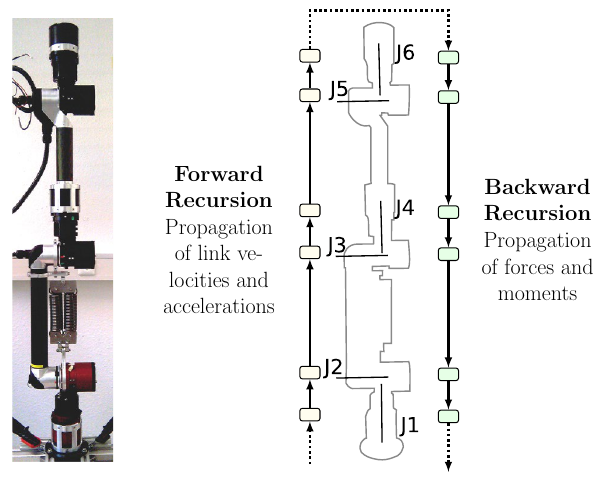
Fig. 8 Left: COMPI manipulator arm (initially without cover). Right: communication procedure of the distributed dynamics computa- tion is shown exemplarily for the